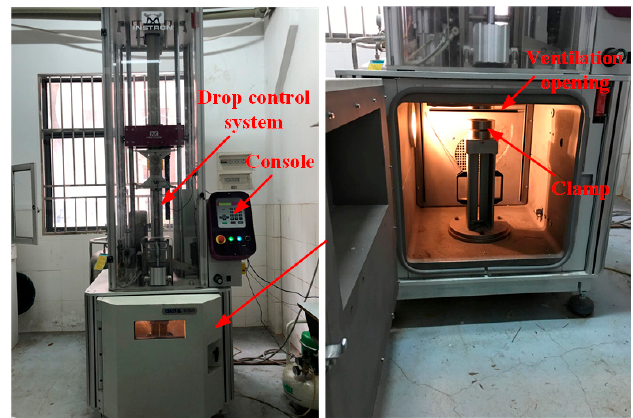
Figure 3. Testing device of the impact tests.